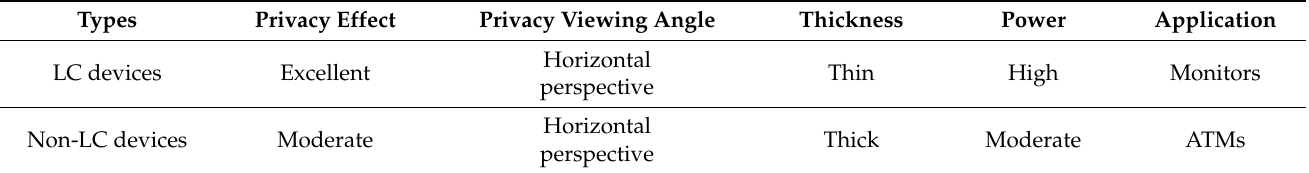
Table 2. Comparison of various LC and non-LC